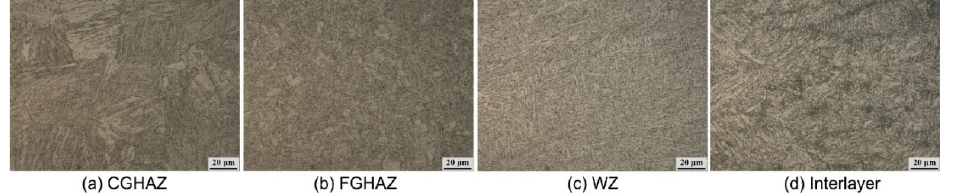
5 of 10 Figure 3. Cross ‐ sections of the narrow ‐ gap GMA welded joints under different welding speeds: ( a ) 350 mm/min; ( b ) 300 mm/min; ( c ) 250 mm/min.